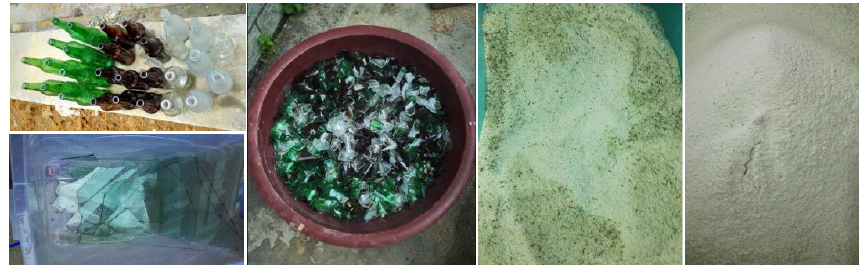
Figure 3. Treatment process of waste glass evolving into glass powder.